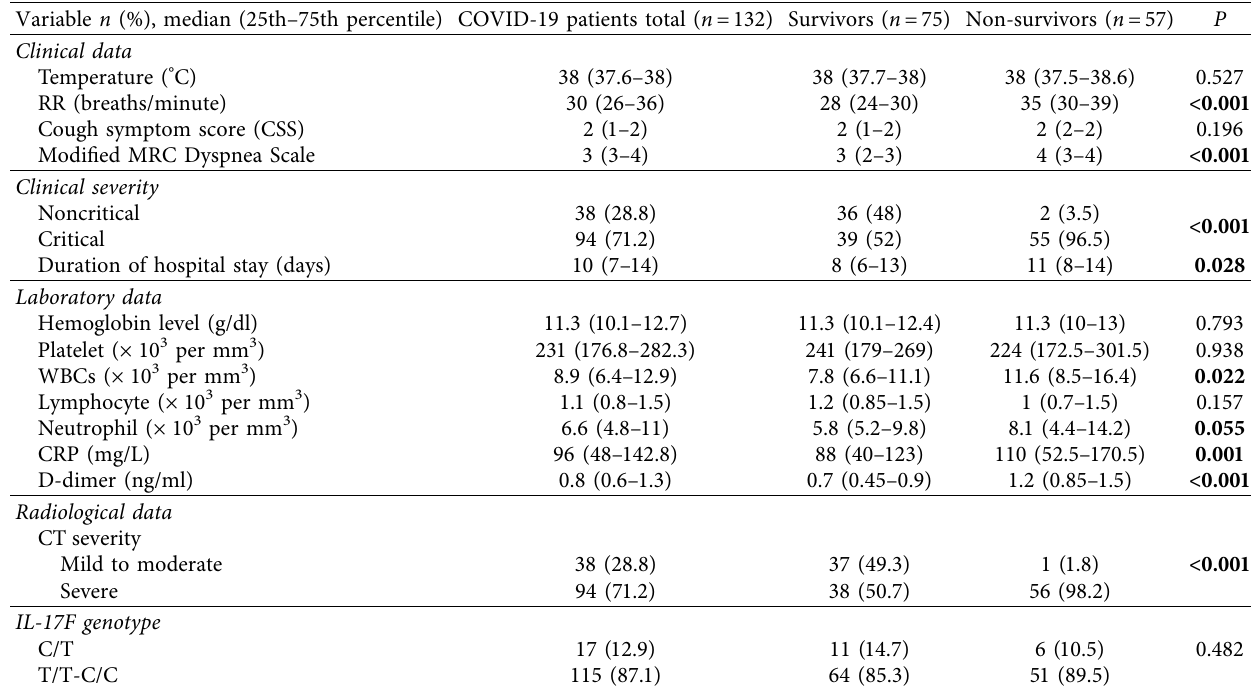
Table 2: Clinical, laboratory, and radiological data of the study COVID-19 patients ( n � 132).